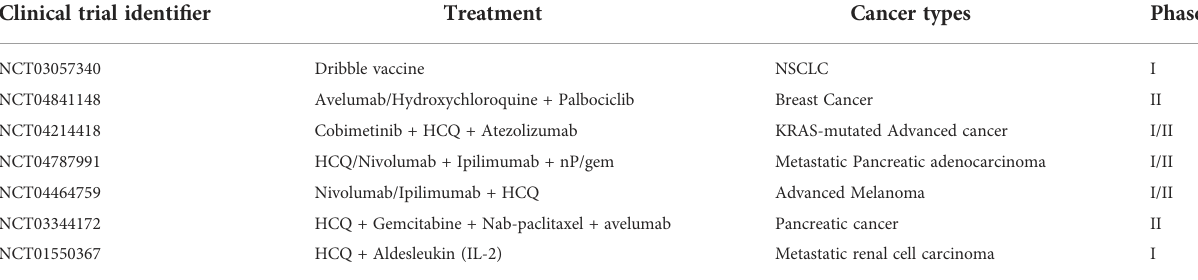
TABLE 3 The ongoing clinical trials about the combinations of immunotherapy with autophagy targeted drugs. Clinical trial identi fi er